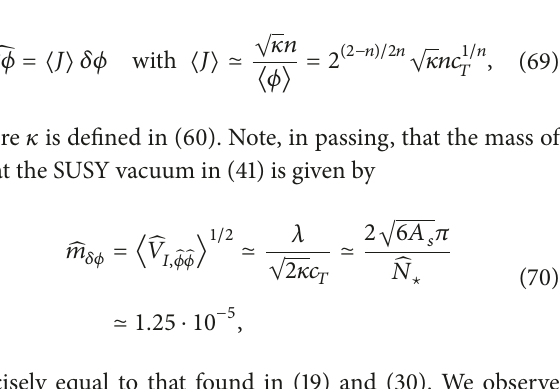
Figure 3: The inflationary potential corresponding to 𝜙 ⋆ and 𝜙 𝑓 are also